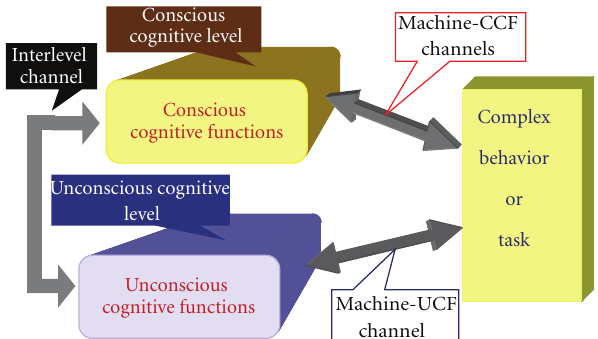
Figure 1: Robot coordinates described by a triplet as P ( x , y , θ